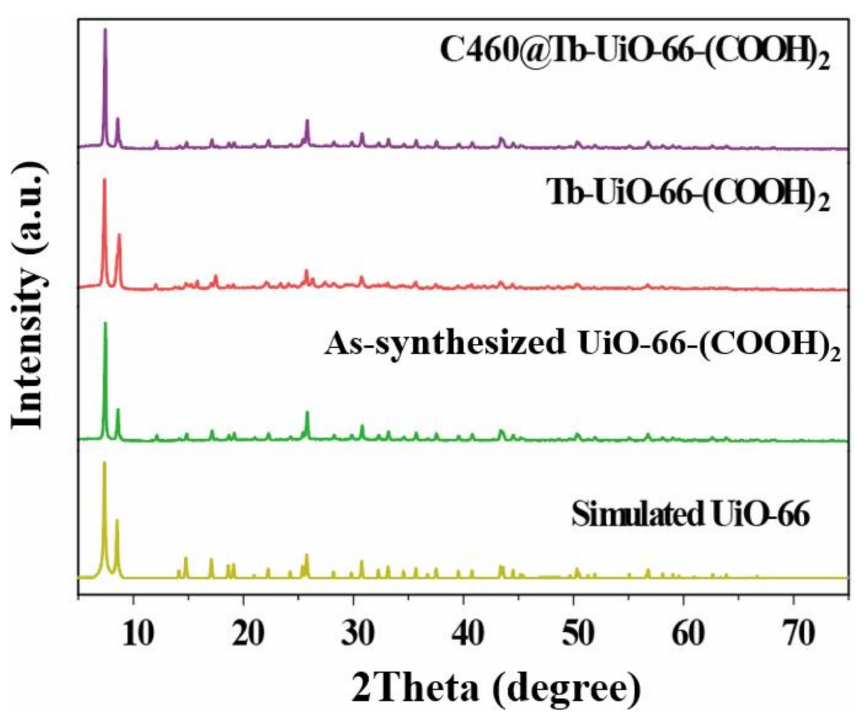
Figure 1. XRD patterns of simulated UiO-66, as-synthesized UiO-66-(COOH) 2 , Tb-UiO-66-(COOH) 2 ,